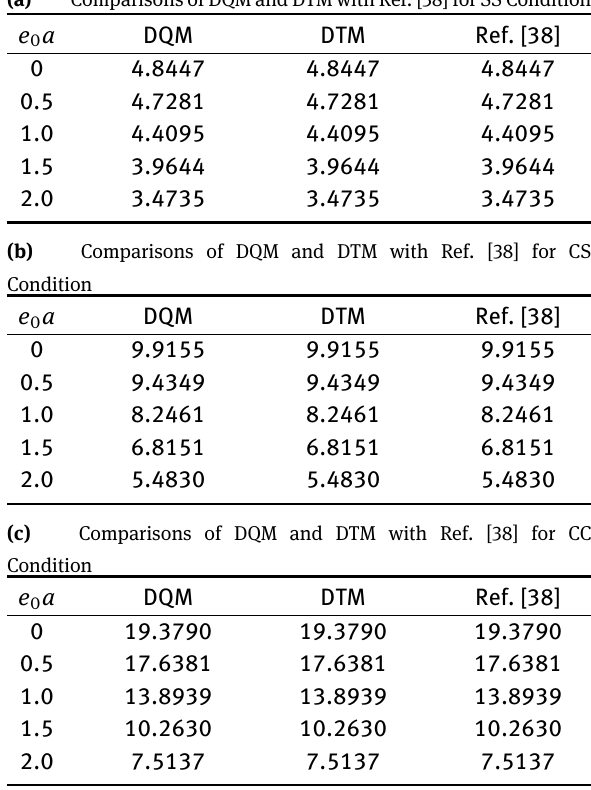
Table 4: Comparisons of DQM and DTM with Ref. [38] (a) Comparisons of DQM and DTM with Ref. [38] for SS Condition